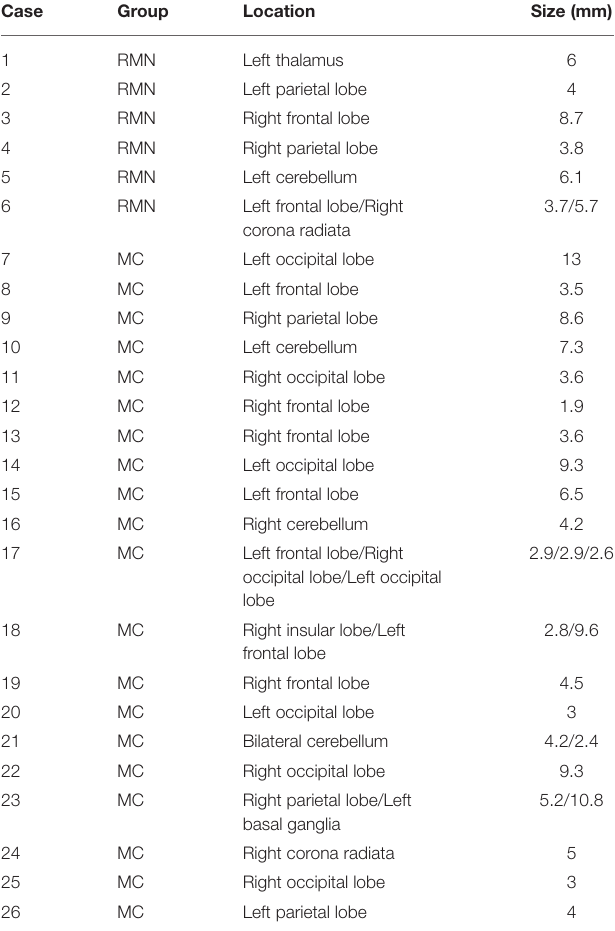
TABLE 3 | Localization, number and size of SCE in 26 patients.